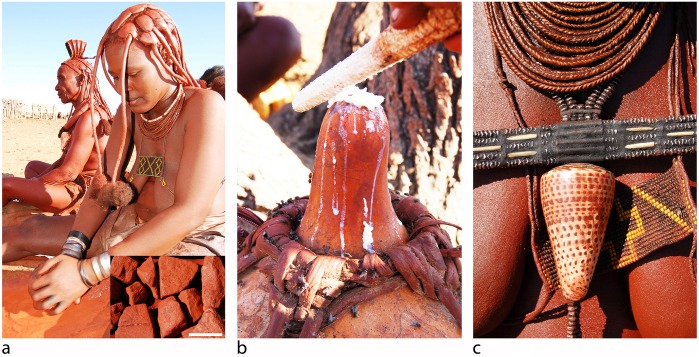
The production and application of otjise.(A) Red ochre powder is obtained by grinding chunks (inset—scale bar is 1cm) between a round upper and a flat lower grindstone, (B) after which it is mixed (at a 1:1 ratio between the palms) with milk-derived clarified butter and (C) applied to the hair, body and ornaments.